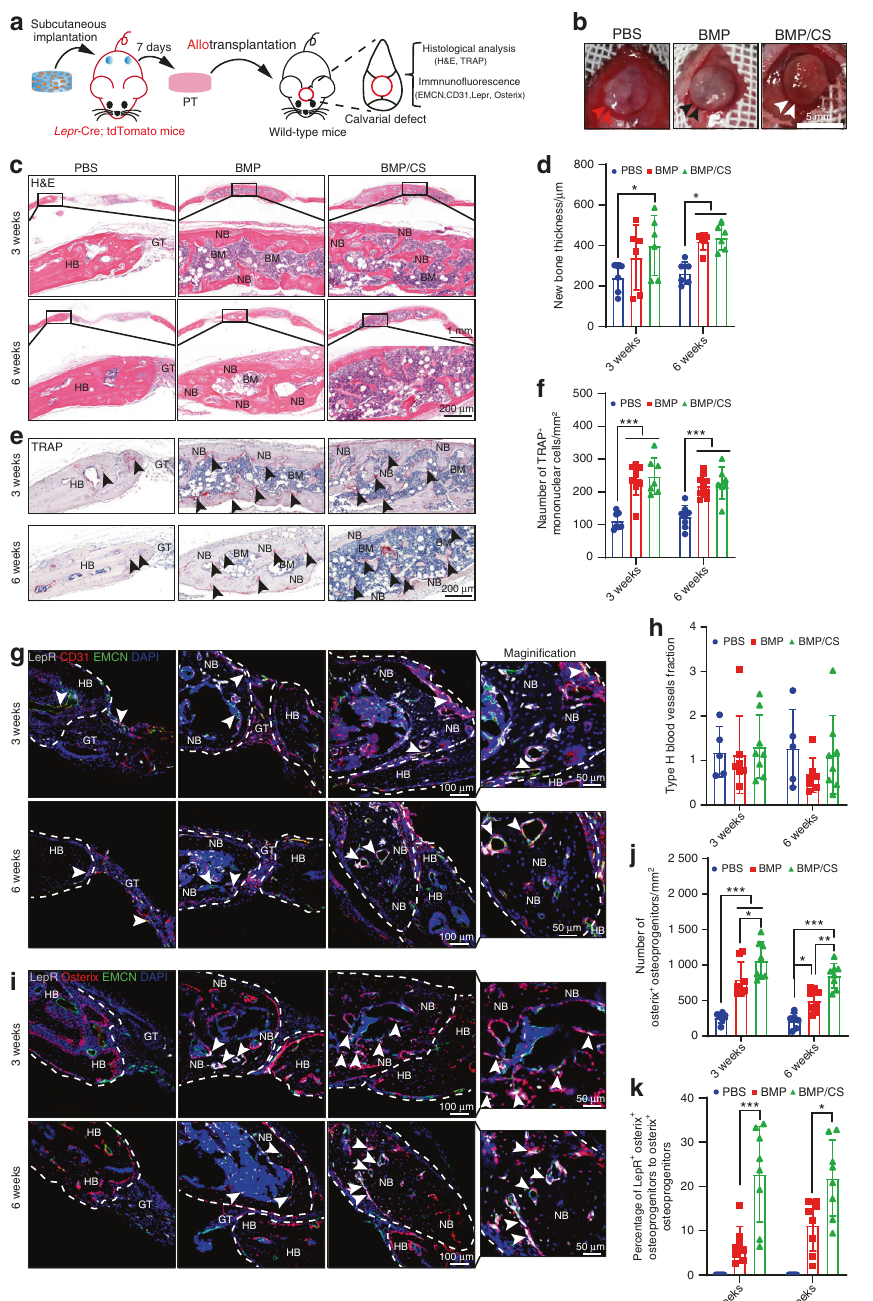
Fig. 3 Functional PTDCs lodged in PTs participate in osteogenesis and osseointegration during allogenic transplantation. a Scheme of the experiments for allogenic transplantation with the PTs from the PBS, BMP, and BMP/CS groups. Freeze-dried PBS-, BMP-, or BMP/CS-loaded scaffolds were subcutaneously implanted in Lepr -cre; tdTomato mice for 1 week ( n = 6). Then, the obtained PTs were engraved for transplantation. b Surgery for allogenic transplantation for critical-sized calvarial defect repair in wild-type mice. Images were taken at the initial surgical procedure. The red arrowhead indicates animals transplanted with allogenic PT from the PBS group, the black arrowhead indicates animals transplanted with allogenic PT from the BMP group, and the white arrowhead indicates animals transplanted with allogenic PT from the BMP/CS group. c – f Representative images and quantitative analysis of H&E ( c , d ) and TRAP ( e , f ) staining of cranial samples from the PBS, BMP, and BMP/CS groups at weeks 3 and 6 after allogenic transplantation in wild-type mice. g – k Representative images and quantitative analysis of immuno fl uorescence staining of type H vessels (EMCN + CD31 + , yellow; g , h ), Osterix + osteoprogenitors (red; i , j ) and Lepr -cre; tdTomato donor-derived osteoprogenitors ( i , k ) in the PBS, BMP, and BMP/CS groups at weeks 3 and 6 after allogenic transplantation in young mice. Granulation tissue GT, bone marrow BM, new bone NB, host bone HB. The black arrowhead indicates TRAP-positive cells ( e ). Lepr -cre; tdTomato-positive cells are white, EMCN-positive cells are green, CD31- and Osterix-positive cells are red, and DAPI is blue (nucleus). The white dashed line indicates the host bone or new bone area ( g , i ). The white arrowhead indicates type H blood vessels ( g ) and LepR + Osterix + osteoprogenitors ( i ). Scale bar (top: low magni fi cation, 1 mm; bottom: high magni fi cation, 200 μ m; c , e ) and (left: low magni fi cation, 100 μ m; right: high magni fi cation, 50 μ m; g , i ). Biological replicates are 5 – 8. Data are presented as the mean ± SD. * P < 0.05, ** P < 0.01, *** P < 0.001, two-way ANOVA followed by Bonferroni ’ s post hoc